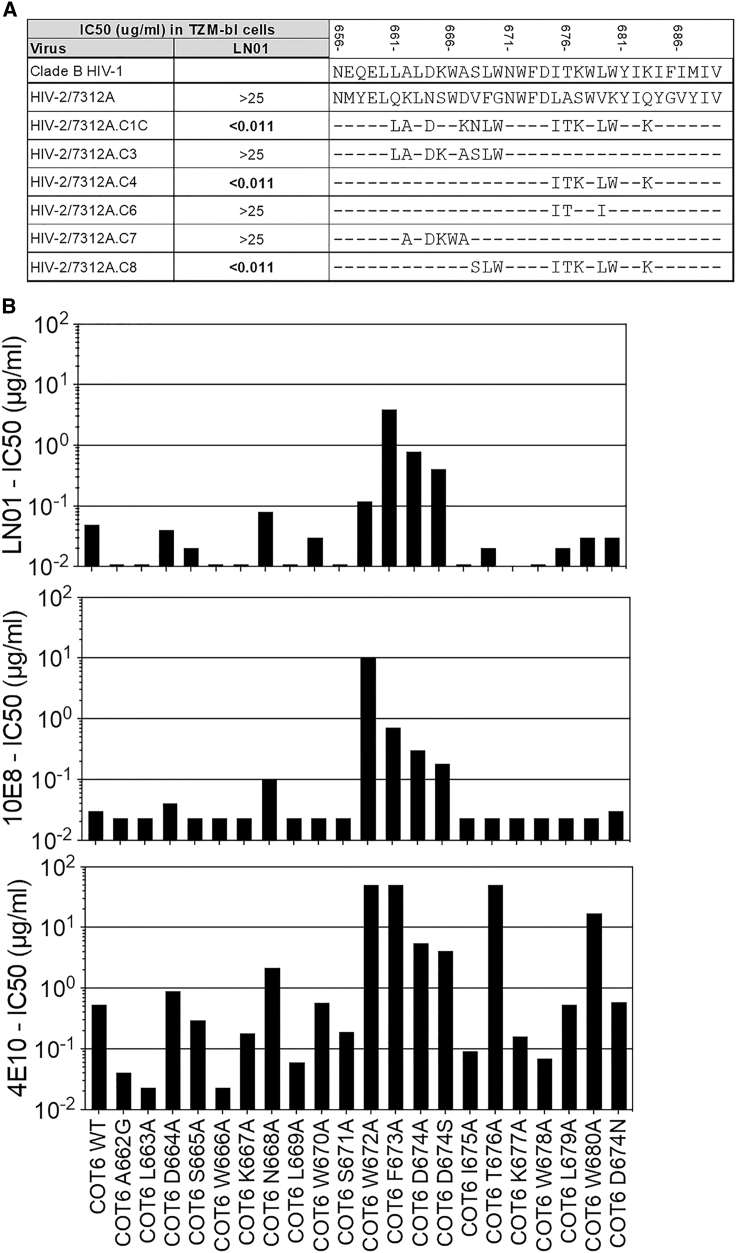
Relevant Residues on HIV-1 PVs for LN01 Binding(A) HIV-2 chimera containing HIV-1 MPER region and parental HIV-2 were used to determined the binding of recombinant LN01. In the table are shown the IC50 (mg/mL) calculated based on the neutralization assay with TZM-bl cells (middle column), and the different mutations in the sequence carried by MPER of each chimeras (right column).(B) The activities of LN01, 10E8, and 4E10 mAbs against several MPER mutants of the COT6.15 virus were assessed. Shown are the IC50 values expressed in μg/mL.